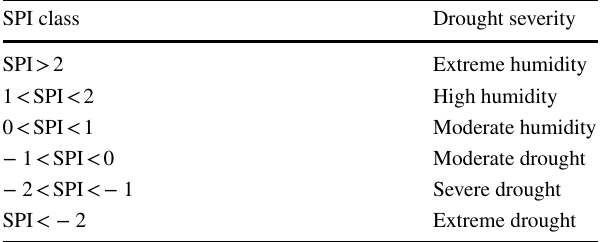
Table 2 Drought classification based on the standardized